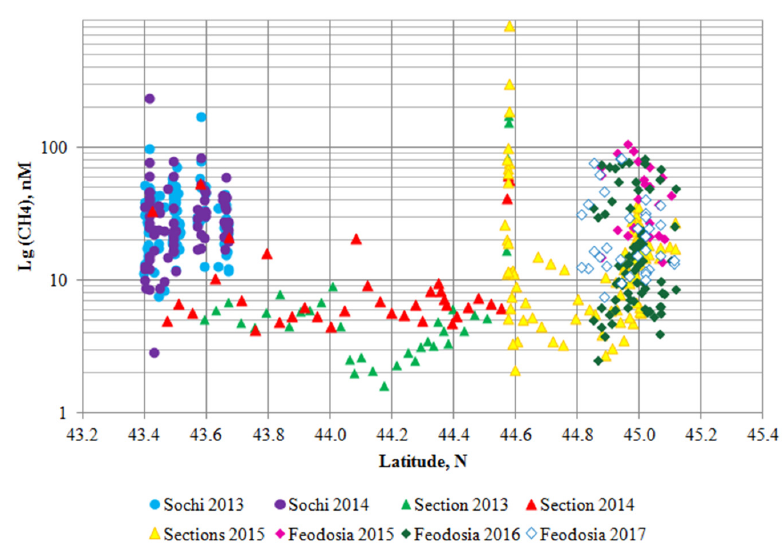
Figure 13. Methane concentrations in the regions of Sochi, Feodosia, and along-shore sections in the northeastern Black Sea (2013–2017).